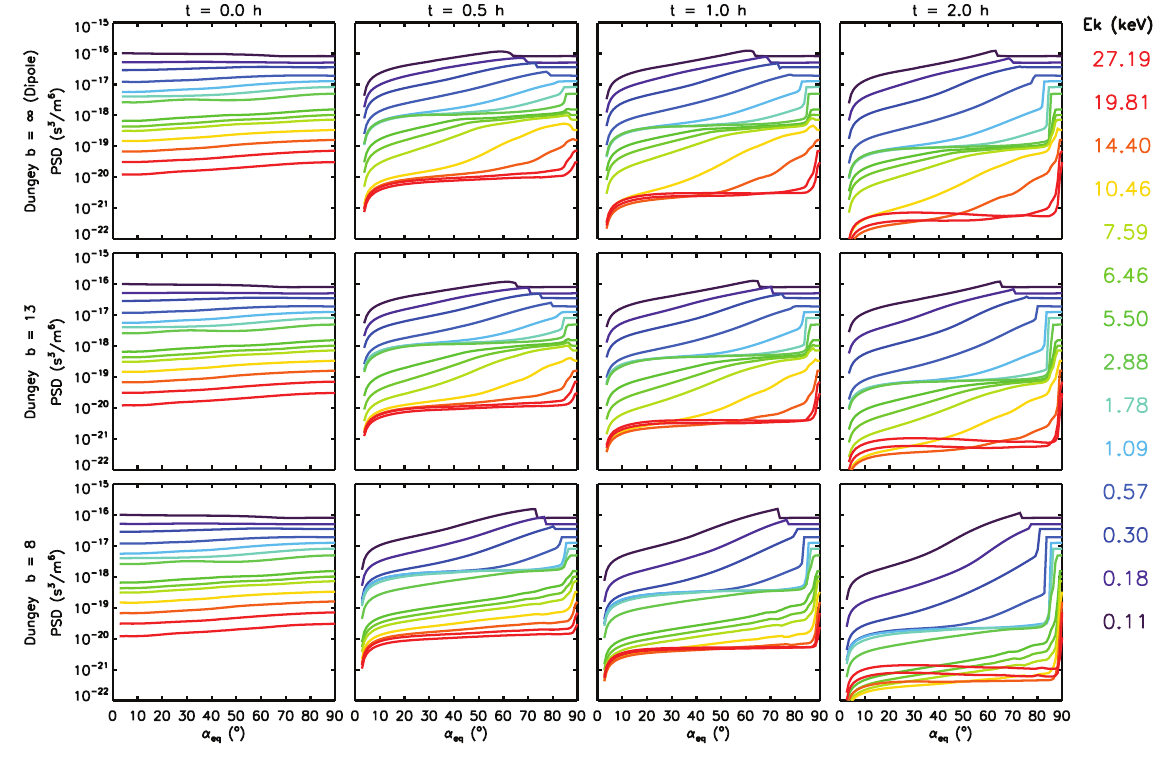
Fig. 5. Evolution of PSD (s 3 m − 6 ) as a function of equatorial pitch angle at selected fixed energies due to nightside chorus at L = 6 from initial condition (column 1) to t = 0 . 5h (column 2), t = 1 . 0h (column 3) and up to t = 2 . 0h (column 4) in the Dungey magnetic models with b =∞ (dipole), 13 and